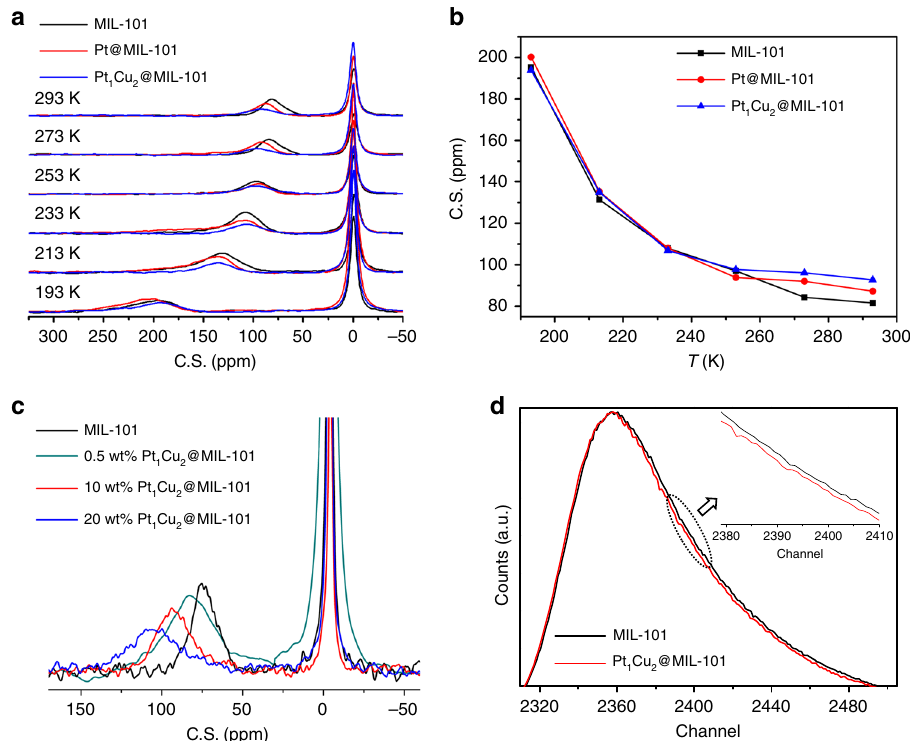
Fig. 4 129 Xe NMR and positron lifetime characterizations. a Temperature-dependent hyperpolarized 129 Xe NMR spectra for MIL-101, Pt@MIL-101, and PtCu@MIL-101. The measurements were performed in the range of 193 – 293 K. b The 129 Xe chemical shift difference for MIL-101, Pt@MIL-101, and Pt 1 Cu 2 @MIL-101 at different temperatures. c Hyperpolarized 129 Xe NMR spectra performed at 293 K for MIL-101, and Pt 1 Cu 2 @MIL-101 with various metal percentages. d Positron lifetime spectra for MIL-101 and 0.5 wt% Pt 1 Cu 2 @MIL-101 based on positron annihilation experiments Table 1 Positron lifetime parameters